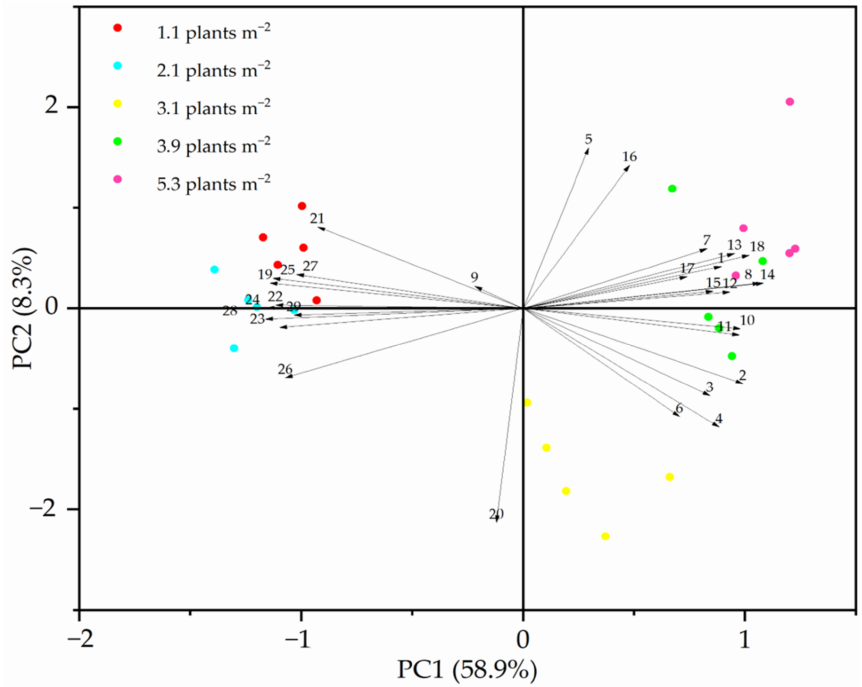
Figure 7. Principal component analysis (PCA) of soil parameters. 1–6, total and available nitrogen, total and available phosphorus, total potassium and organic matter in the 0–10 cm layer; 7–12, total and available nitrogen, total and available phosphorus, total potassium and organic matter in the 10–20 cm layer; 13–18, total and available nitrogen, total and available phosphorus, total potassium and organic matter in the 20–30 cm layer; 19–20, soil fractal dimension in the 0–20 and 20–40 cm layer; 21–23, pH in the 0–10, 10–20, and 20–30 cm layer; 24–29, the gravimetric soil water content of the 0–20 and 20–40 cm layer in June, July and